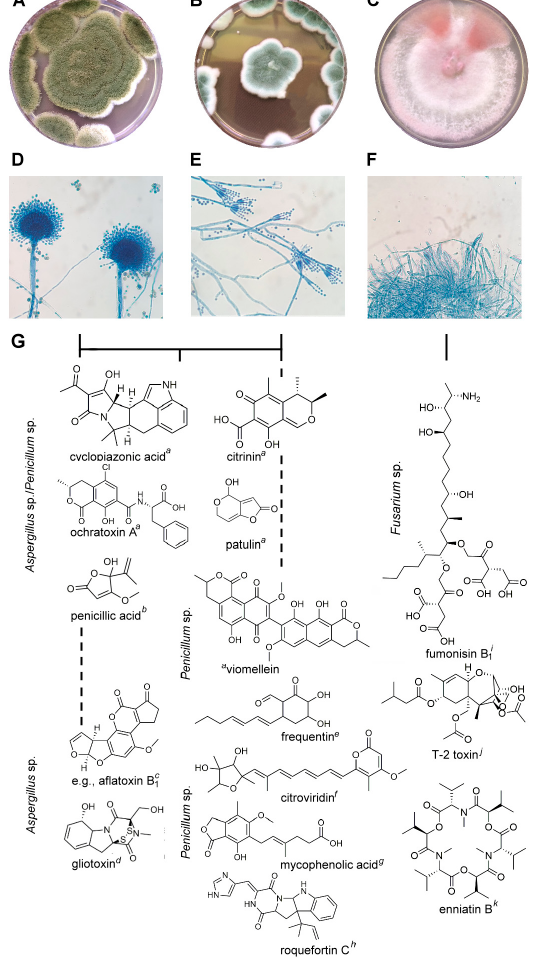
Figure 1. Colonies of mycotoxigenic fungi grown in Sabouraud Dextrose Agar and their respective microscopic images after staining with lactophenol cotton blue. ( A , D ) Aspergillus flavus ; ( B , E ) Penicillium sp.; ( C , F ) Fusarium solani . ( G ). Structures of model mycotoxins produced by the aforementioned fungal species. a benzopyrans; b isopropylidene tetronic acid; c difuranocoumarin; d